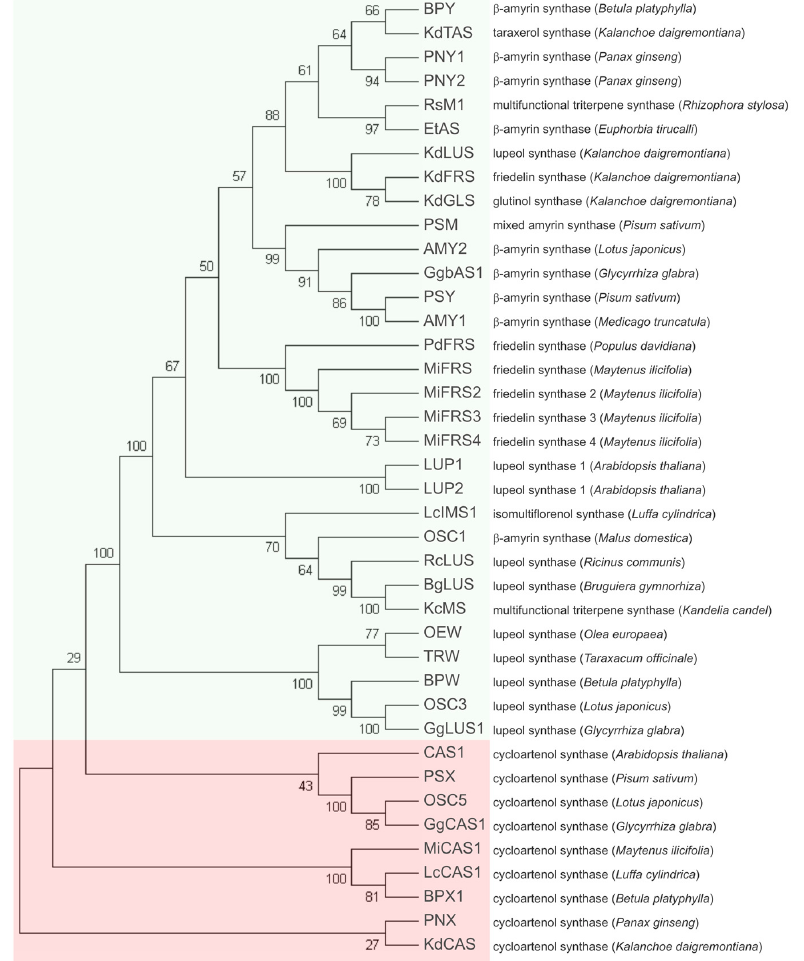
Figure 2. Phylogenetic analysis of Mi FRS among deposited protein sequences of other OSCs. The global multiple alignment among protein sequences of OSCs from different plants (accession data shown in Table S2) was done using ClustalW tool and phylogenetic tree was built in MEGA7 software. The percentage of replicate trees in which the associated taxa clustered together in the bootstrap test (1000 replicates) are shown next to the branches. Green box shows the clusterization of pentacyclic triterpene synthases, separated from the group of cycloartenol synthases, whose cluster is marked in the light red box. The group of friedelin synthases from M. ilicifolia is highlighted in green. Notice that Pd FRS and Mi FRS probably have a common ancestor.